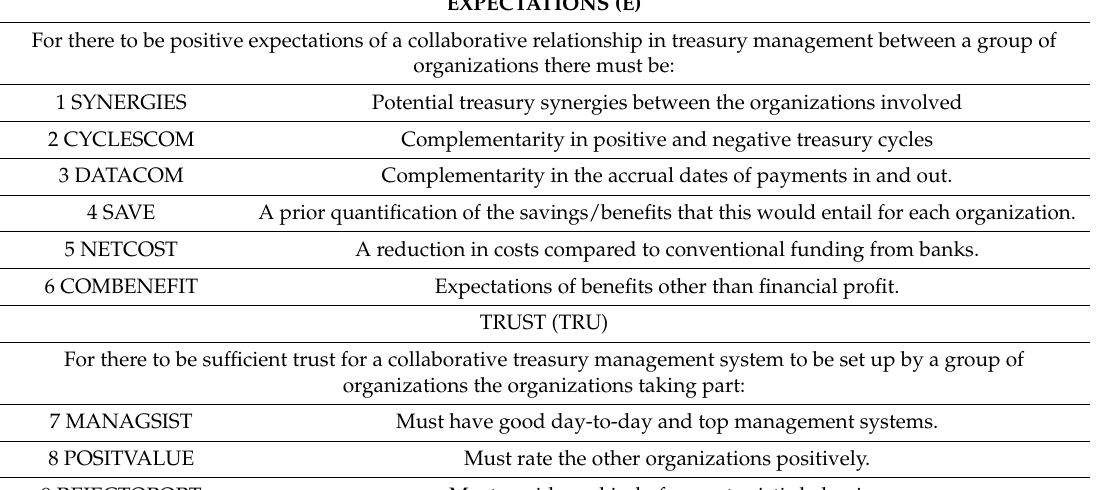
Table A1. Questions of the questionnaire base on a Likert scale. EXPECTATIONS